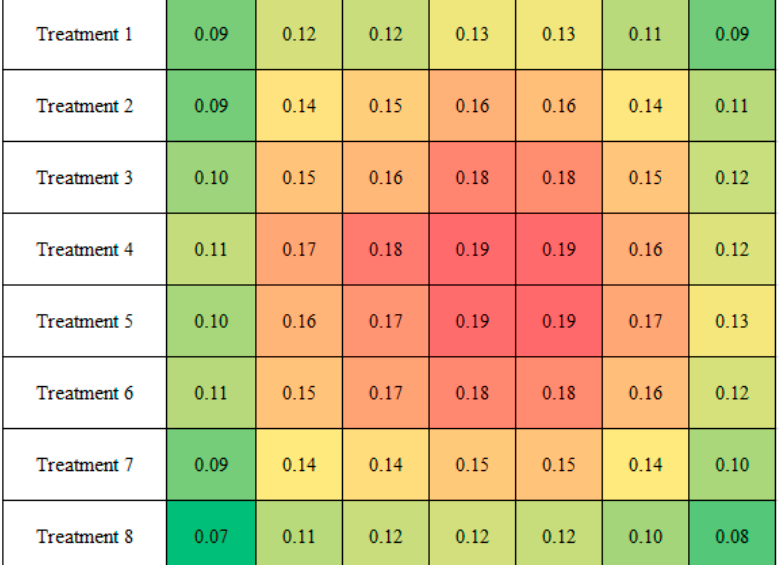
Figure A2. UV ‐ C (222 nm) treatment inactivation curve on aerosolized PRRSV. One ‐ stage (dashed line) and two ‐ stage (solid line) inactivation curves were drawn. PRRSV survival is expressed as log 10 (N t /N 0 ), not as a percentage (%) as shown in Figure 3. In Appendix B, the light intensity for UV-C (254 nm) in Figure A5 needs to be corrected. The original version: